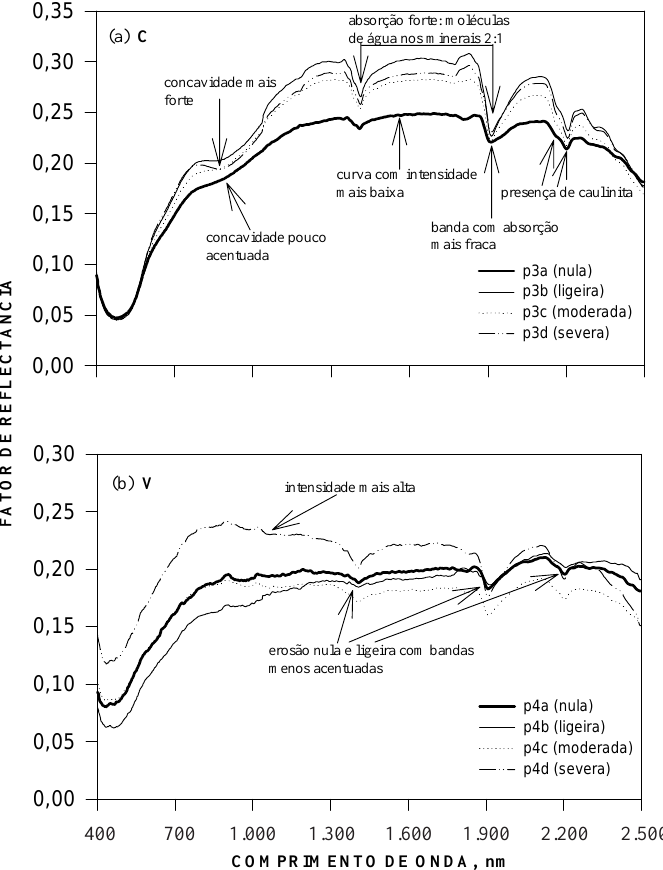
Figura 3. Dados espectrais obtidos com sensor terrestre do Cambissolo C (a) e Vertissolo V (b) designados por diferentes níveis de